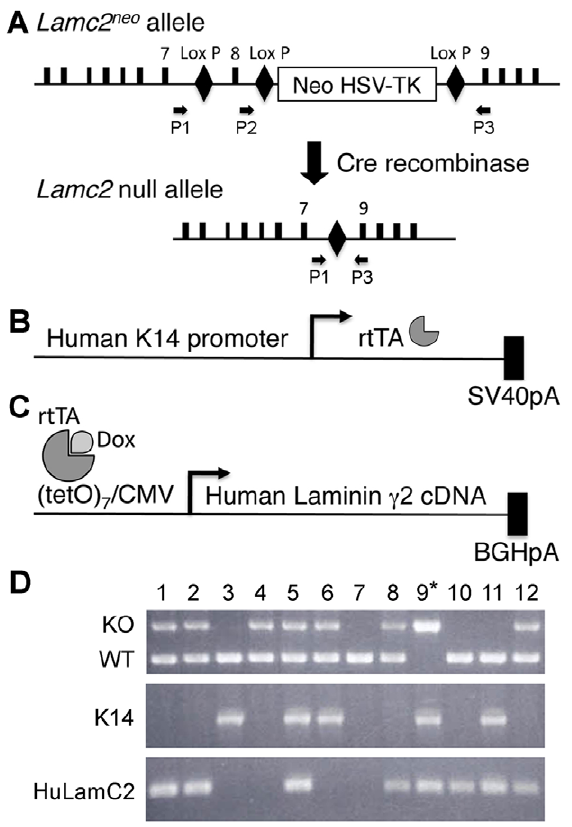
Figure 1. Schematic diagrams of the Lamc2 allele and transgenes used in these studies and genotyping. (A) Lamc2 null allele is generated by Cre recombinase, which removes exon 8 and the Neo-TK insert. Primer locations are indicated. (B) The K14-rtTA transgene contains a human keratin 14 (K14) promoter driving the reverse tetracycline transactivator (rtTA) and a SV40 poly A signal sequence. (C) The TetO-HuLamC2 transgene contains seven copies of the tetracycline operator (tetO) with a CMV minimal promoter driving the human laminin c 2 cDNA and a bovine growth hormone polyA signal sequence. The binding of doxycycline (Dox) to the rtTA promotes recruitment and binding to the tetO and activation of the promoter. (D) PCR analysis of genomic tail DNA of the Lamc2 allele was performed using primers P1, P2, and P3. The mutant allele was detected with primer pair P1–P3, and the wild-type (WT) allele was detected using primer pair P2–P3. The K14-rtTA transgene was detected using K14- and rtTA-specific primers. The human laminin c 2 transgene was detected using primers specific to human laminin c 2. Mice that were a knockout for the Lamc2 allele and carried both the K14-rtTA and the TetO- HuLamC2 transgenes ( # 9) were ‘‘rescued’’ Lamc2 KO mice.